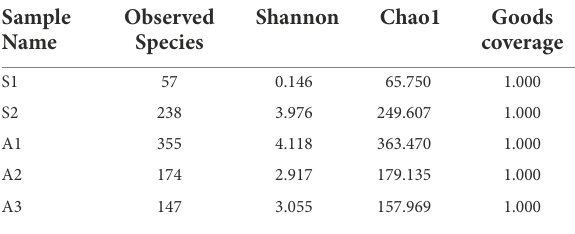
TABLE 2 Alpha diversity indices